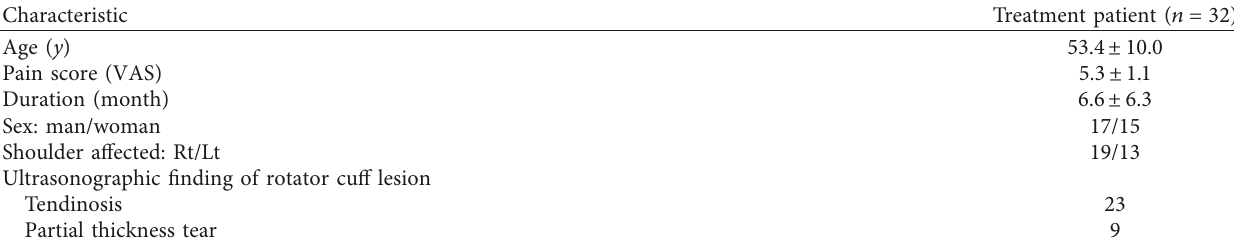
Table 1: Baseline characteristics of patients ( n � 32).